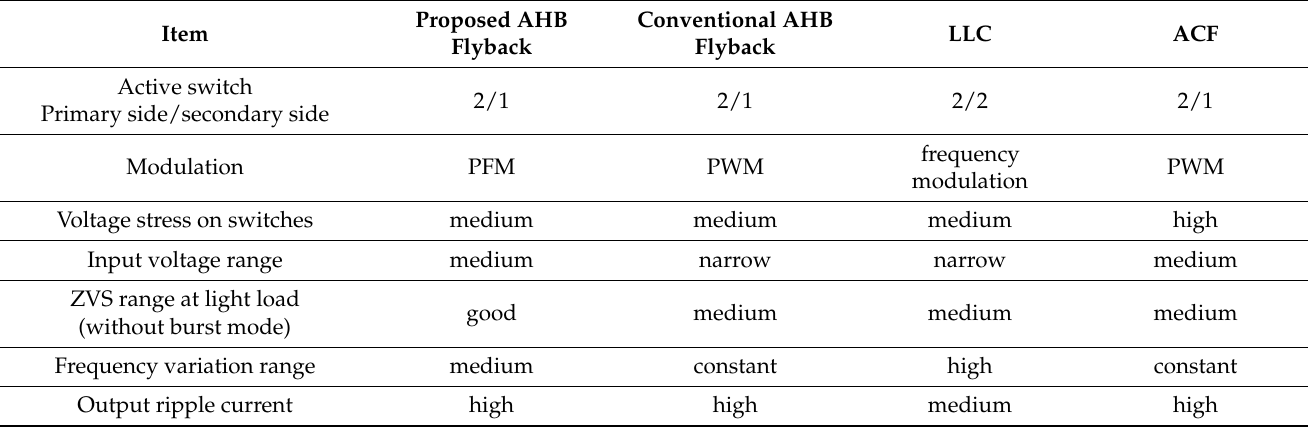
Figure 17. Photographs of the proposed prototype ( a ) view of top side; and ( b ) view of bottom side. Table 3. Measured results of phase margin and gain margin.